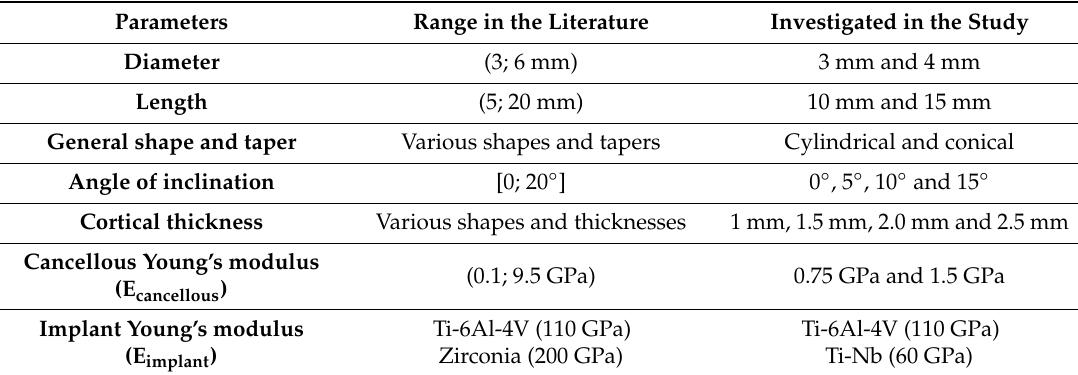
Table 3. Range of the parameters in the literature and investigated values in the